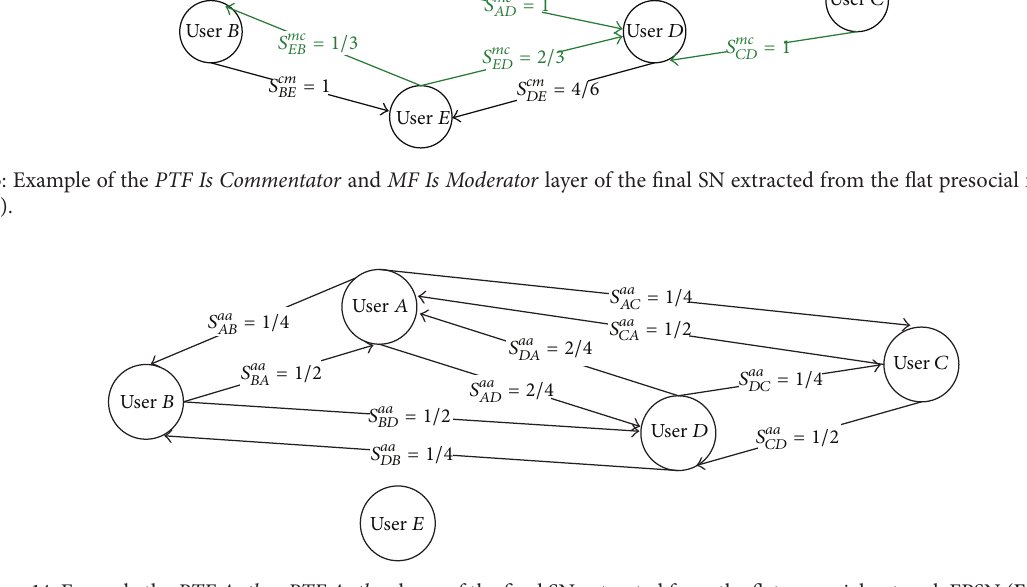
Figure 14: Example the PTF Author PTF Author layer of the final SN extracted from the flat presocial network FPSN (Figure 12).